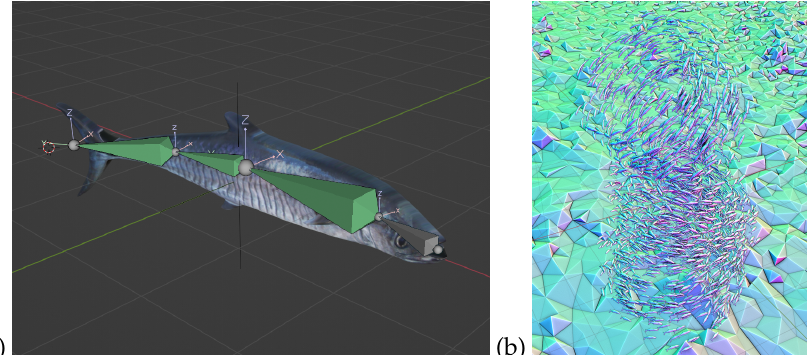
Figure 16. ( a ) Rigged fish model with four bones and bone constraints (green colored, copy rotation of the main bone at the head region) to create a wiggle animation; ( b ) shows the model used in a particle system influenced by a force field in the virtual environment created by photogrammetry (MatCap coloring for 3D representation).